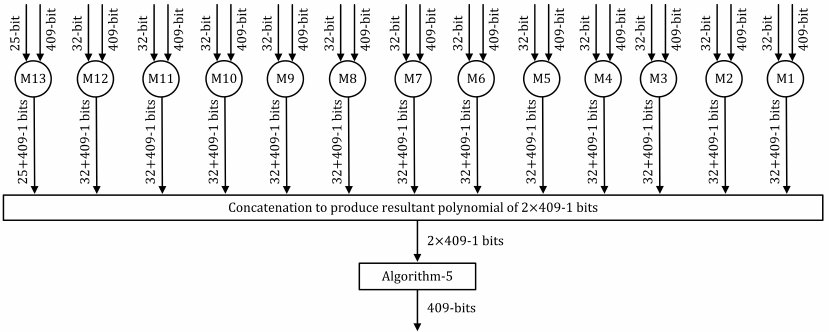
Figure 5. Digit-parallel multiplier over GF ( 2 409 ) .